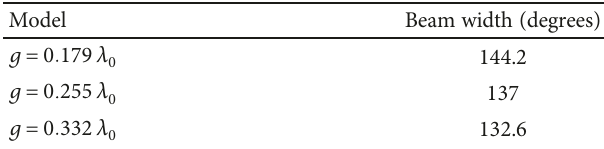
Figure 9: 3dBi beam width comparison for the di ff erent corrugation periods. Table 2: 3dBi beam widths of the di ff erent corrugation